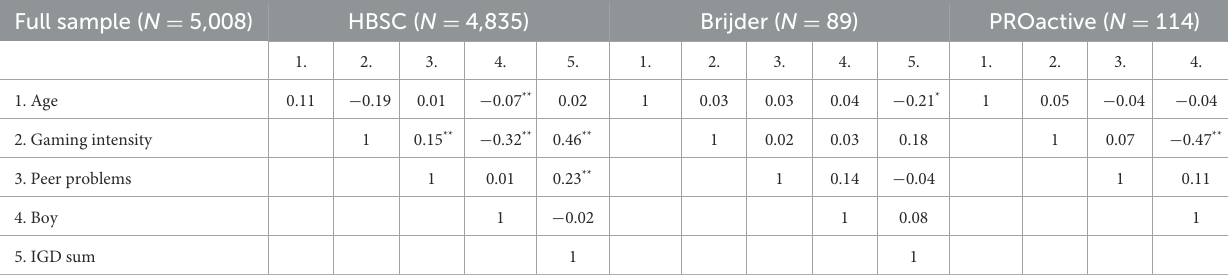
TABLE 2 Pearson’s correlation coefficients for age, gaming intensity, peer problems, sex, and IGD. Full sample ( N = 5,008)